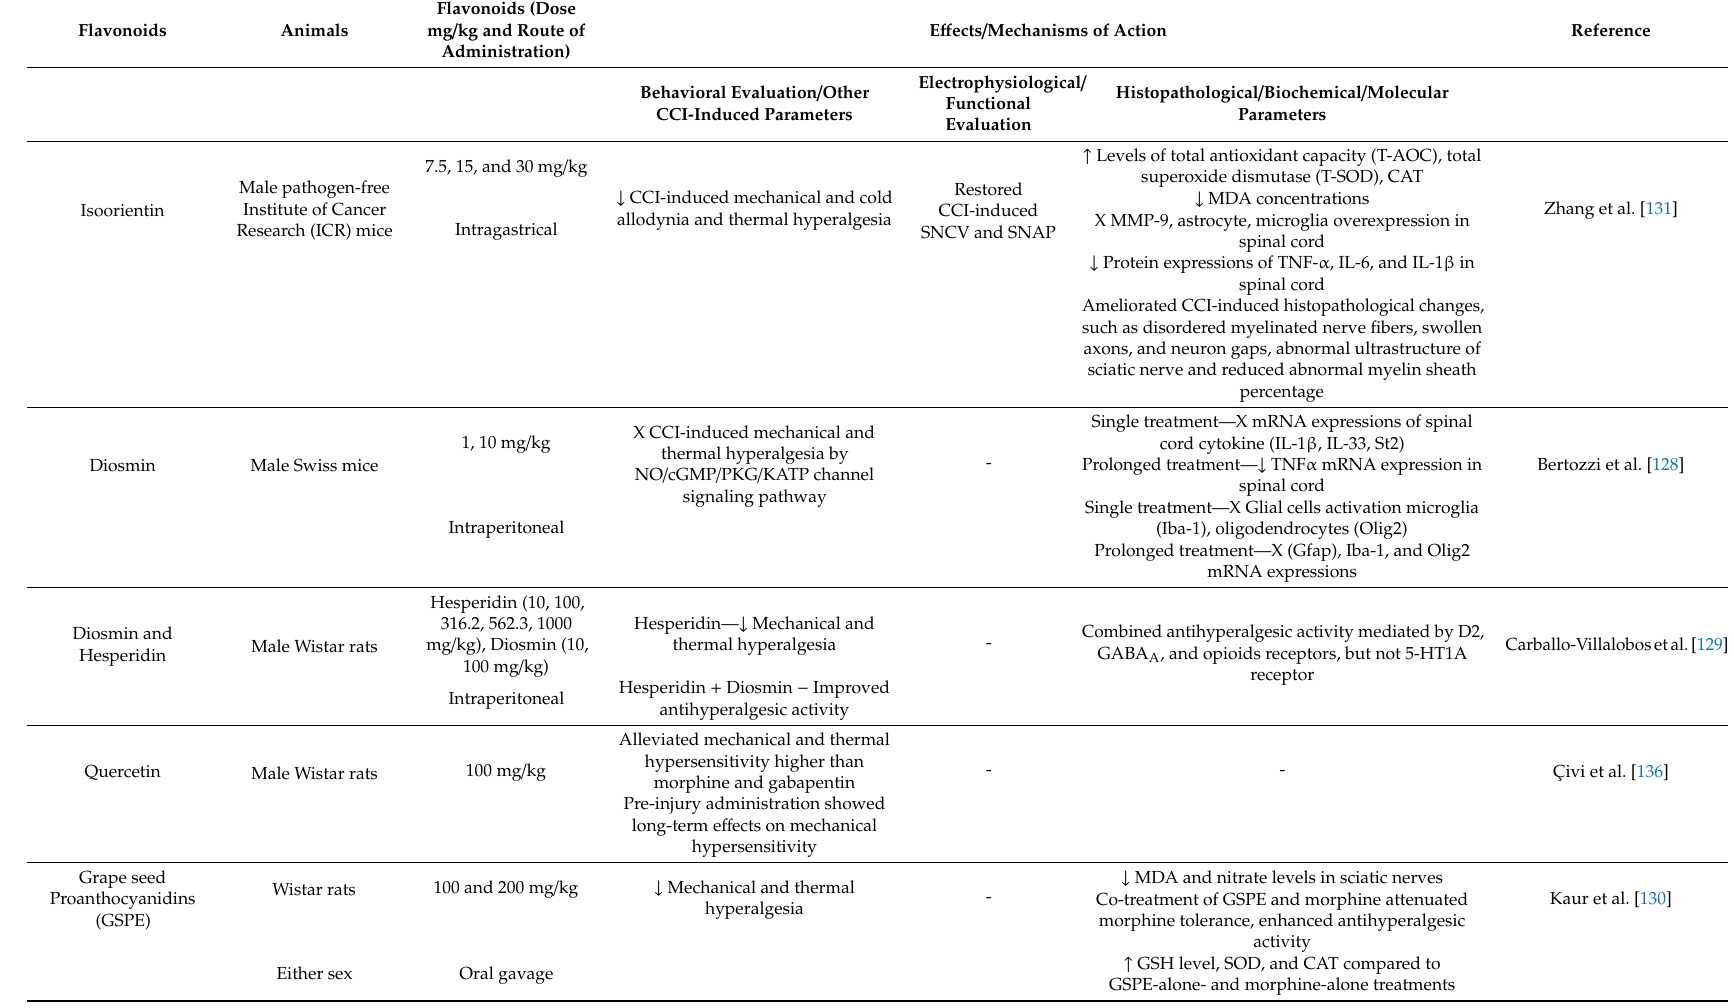
Table 5. E ff ects of flavonoids on sciatic nerve chronic constriction injury